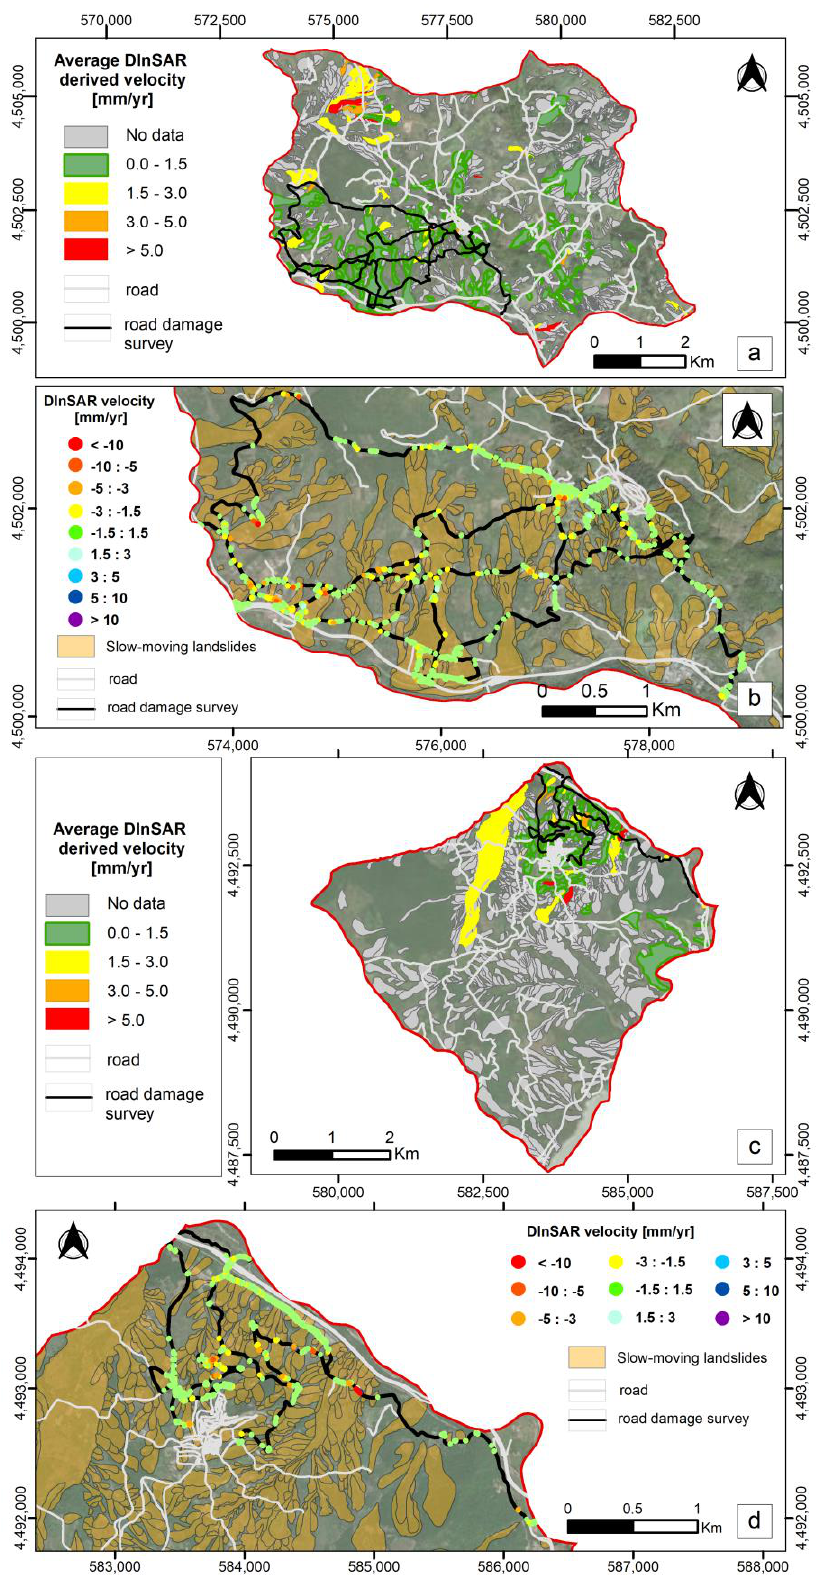
Figure 5. Maps of the slow-moving landslides for Vaglio Basilicata ( a ) and Trivigno ( c ) distinguished according to the average DInSAR-derived velocity values with close-up view of yearly V LOS of analyzed coherent DInSAR benchmarks and assumed as indicators of a state of movement for the TZU road in Vaglio Basilicata ( b ) and Trivigno ( d